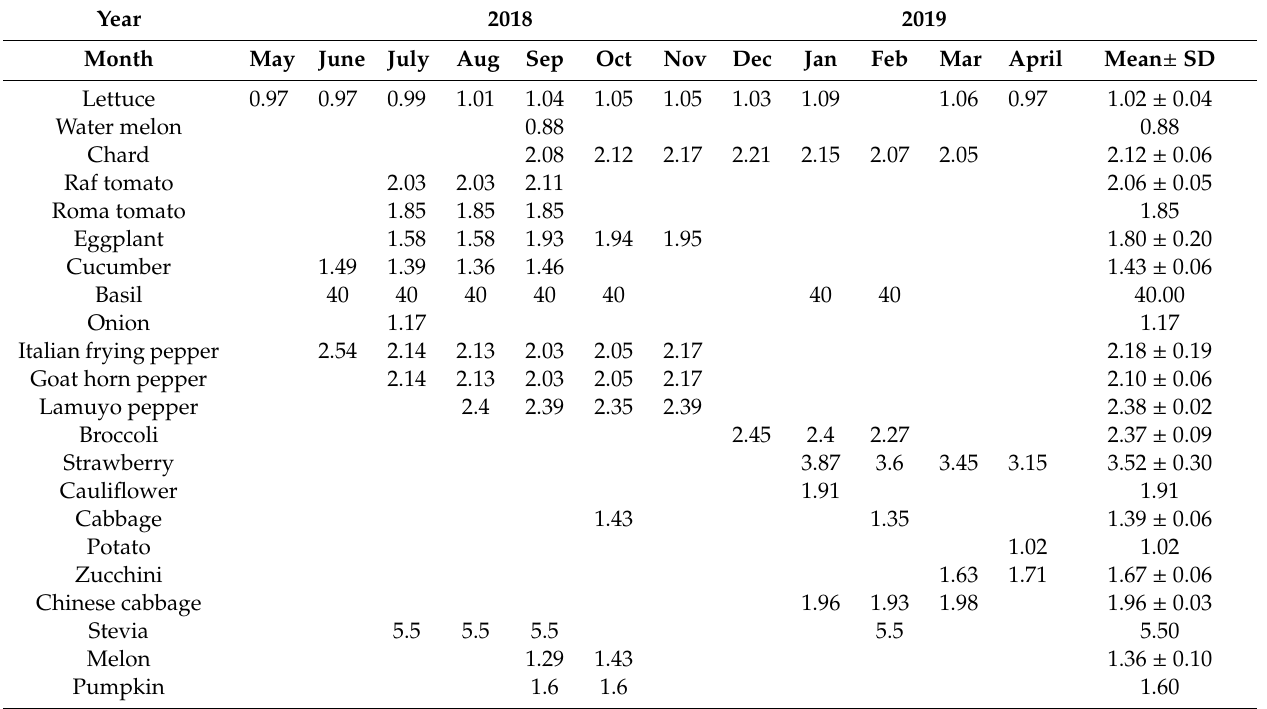
Table A1. Horticultural crops grown in the SAS and market prices ( € kg − 1 ) used each month for the produce obtained (VAT